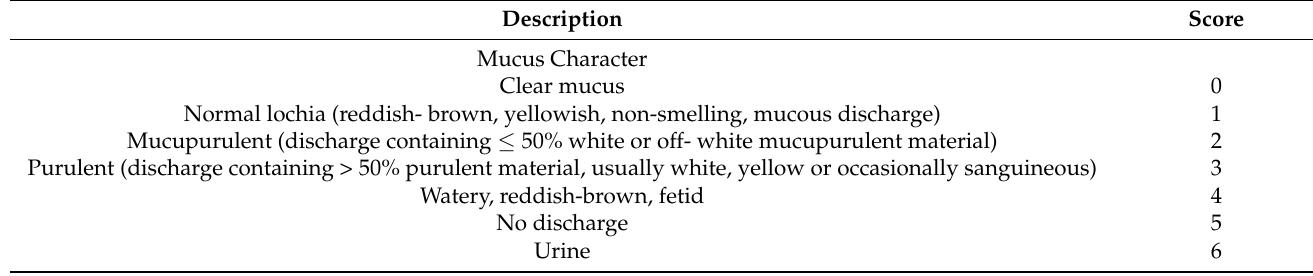
Table 1. The assessment scheme of the character of vaginal discharge. Description Score Mucus Character Clear